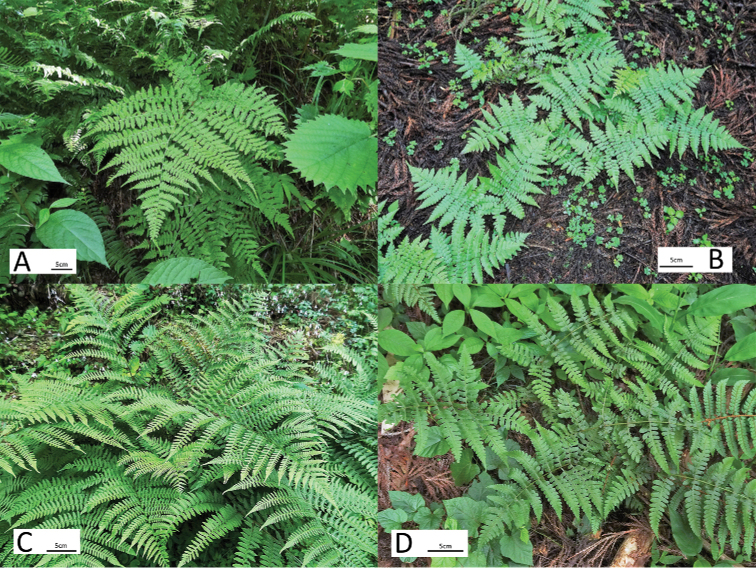
Wild plants of AAthyrium
crenulatoserrulatumBAthyrium
bipinnatumCAthyrium
×
christensenianumDAthyrium
decurrentialatum.